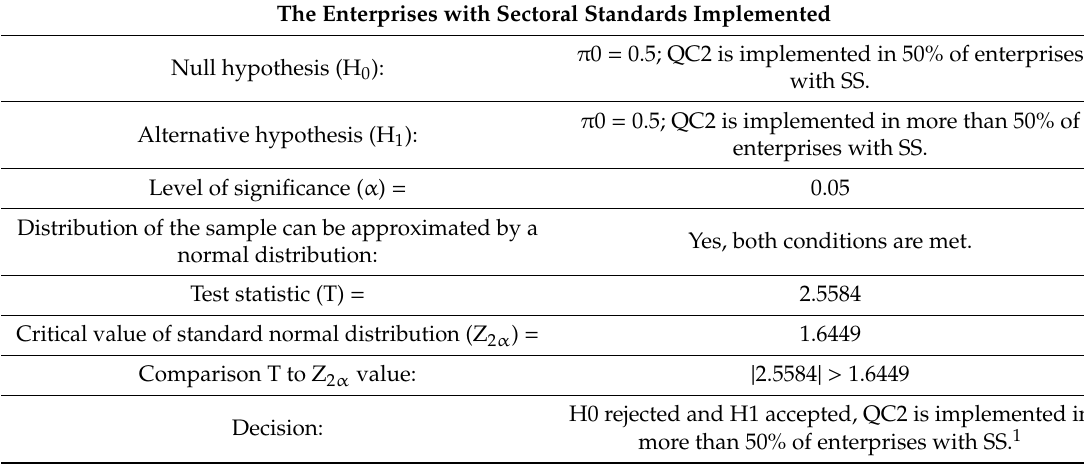
Table 7. The enterprises with sectoral standards implemented.